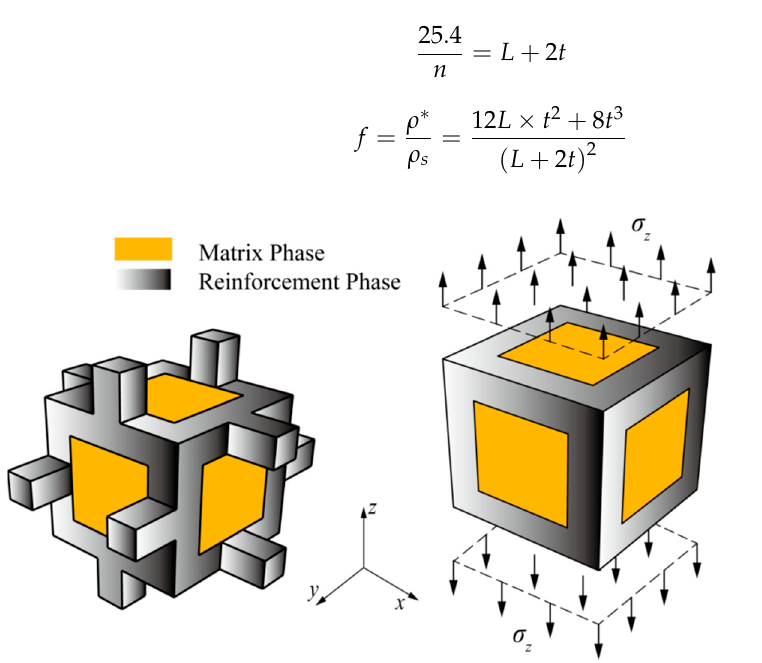
Figure 1. The computational model for representative volume elements and uniaxial tensile of metal/polymer IPC.